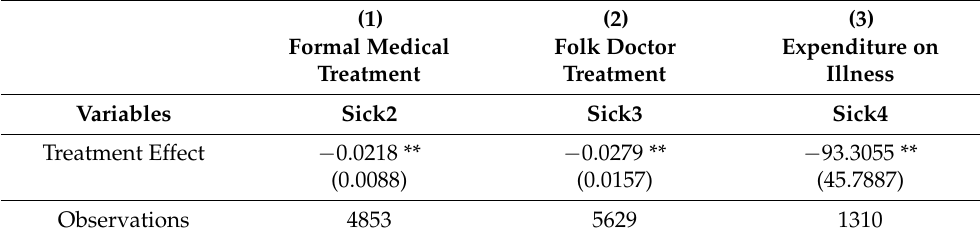
Table 3. Robustness of alternative dependent variables.